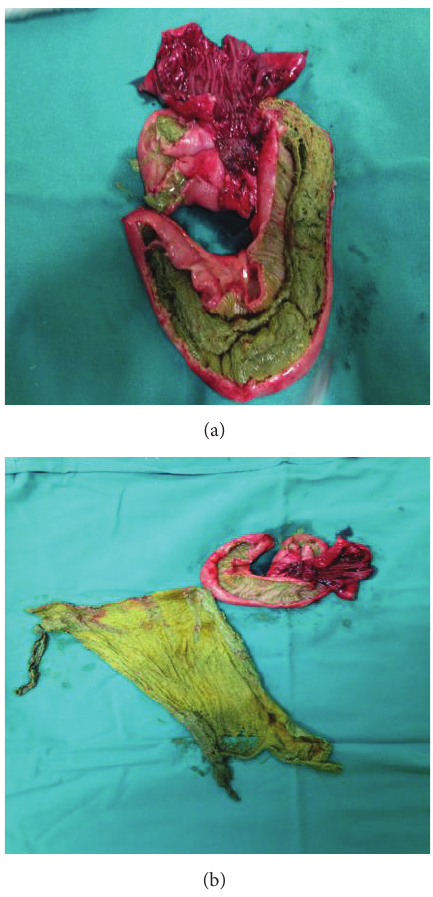
Figure 4: Images of the resected specimen showing the retained foreign